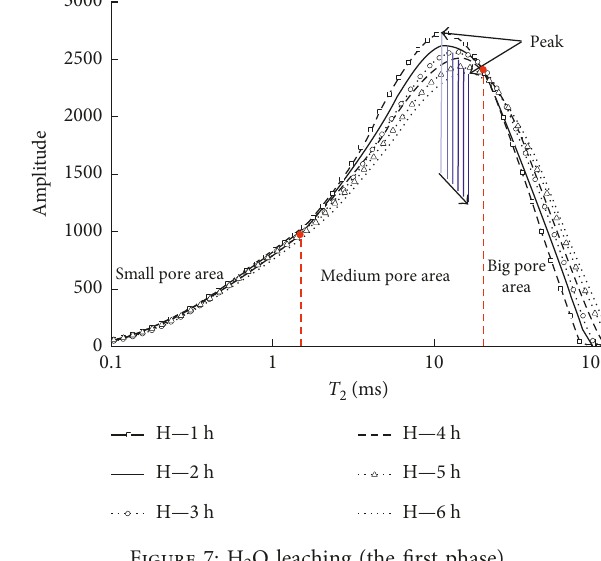
Figure 7: H 2 O leaching (the first phase).